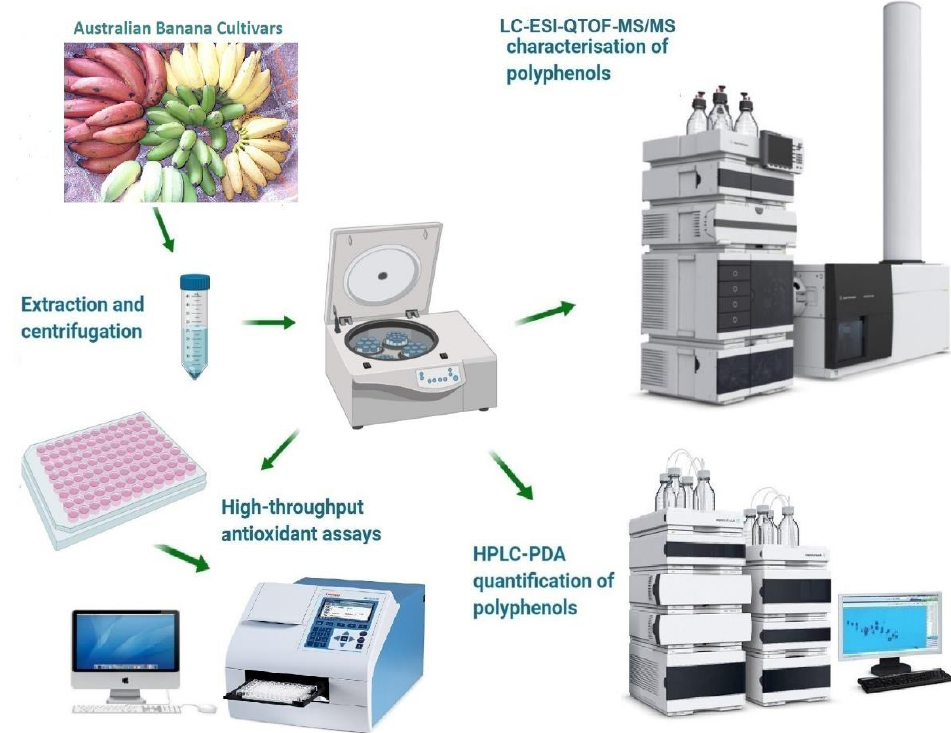
Figure 1. Graphical abstract and schematic layout of this